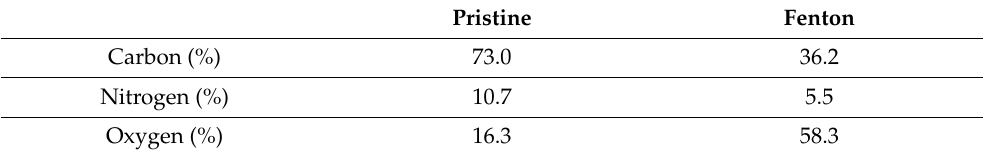
Table 1. Elemental compositions of pristine and Fenton cross ‐ linked membranes according to XPS.